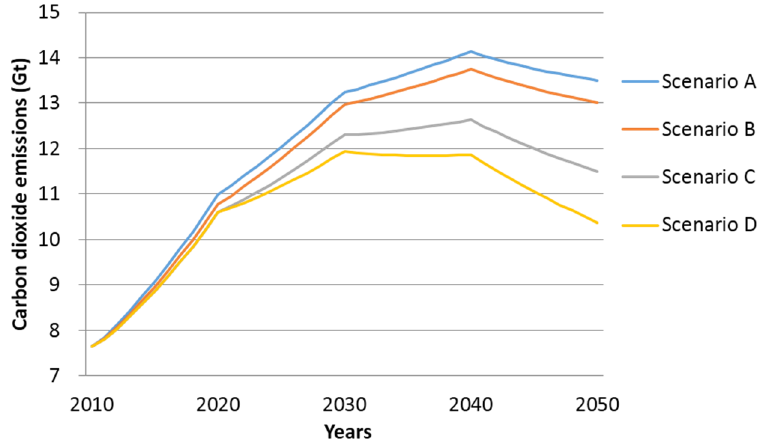
Figure 10. Carbon emission trends in different low-carbon supply